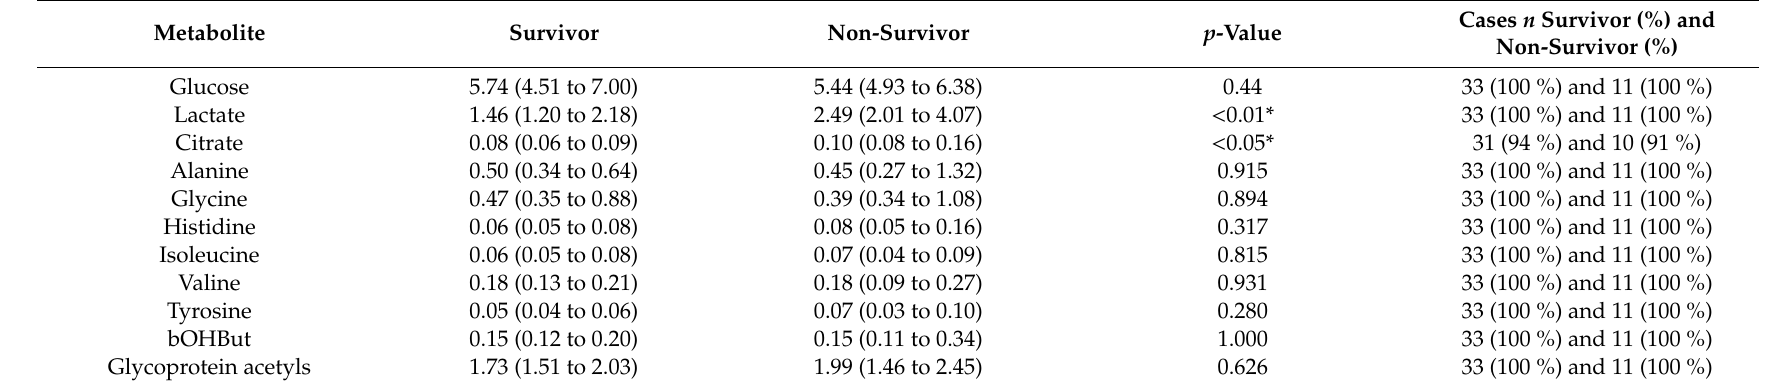
Table 3. Comparison of metabolite concentrations in sera between sepsis survivors and non-survivors. Serum levels are presented as mmol / L. Median concentrations with 25th to 75th percentiles are shown. p < 0.05 is considered significant, and those values are marked with an *. bOHBut =